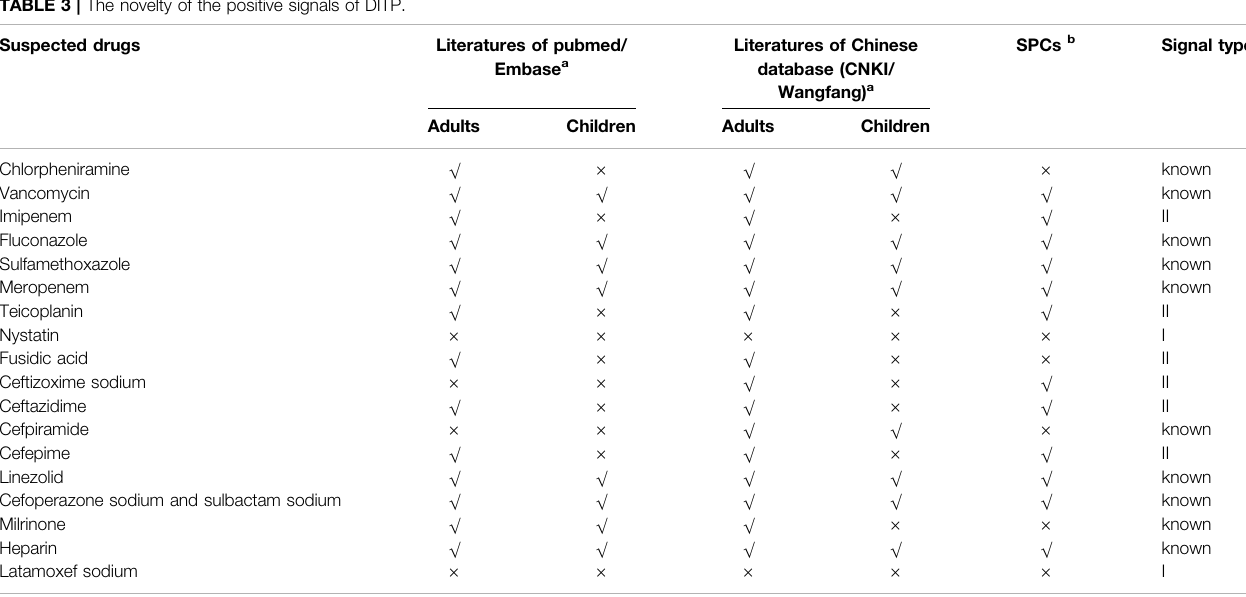
TABLE 3 | The novelty of the positive signals of